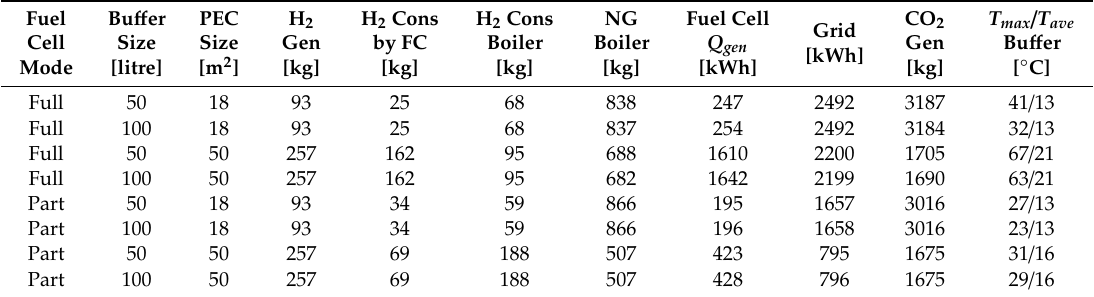
Table 5. Parameters and settings variation for finding the best selection.